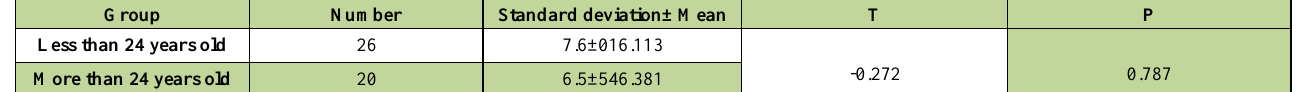
Table 7. Comparison of mean difference of herb toothpaste index between two age groups.